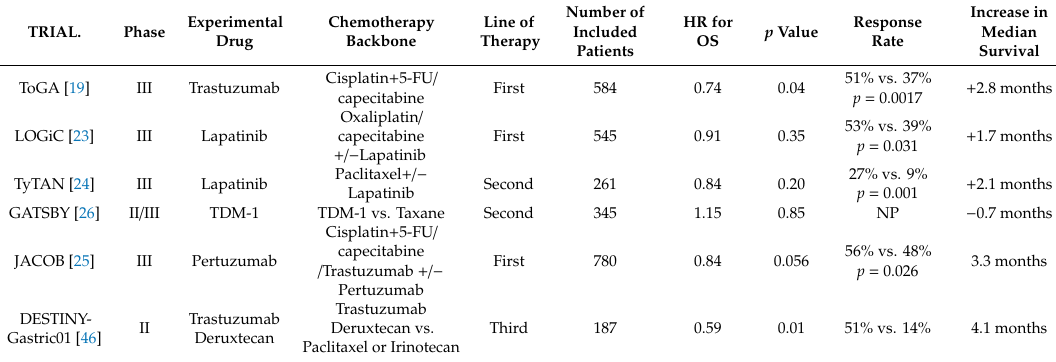
Table 2. Randomized clinical trials testing anti-epidermal growth factor receptor (HER)2 blocking agents in HER2-amplified advanced